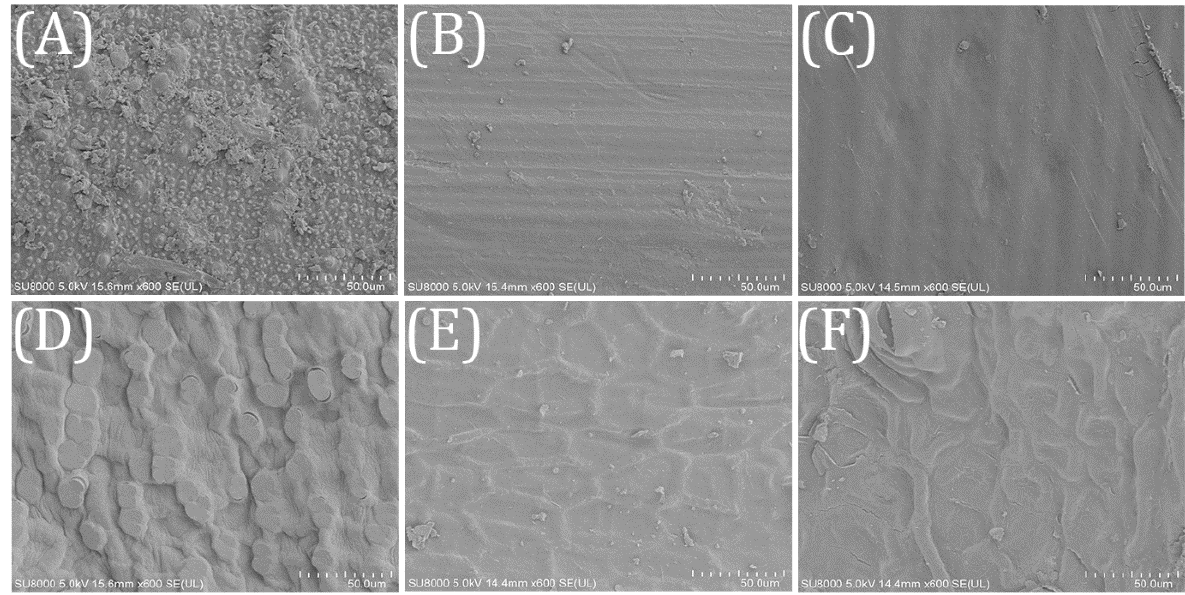
Figure 2. SEM for the investigated agricultural wastes (×500) ( A ) RS; ( B ) WS; ( C ) CS; ( D ) CC; ( E ) SS; (F) SH.